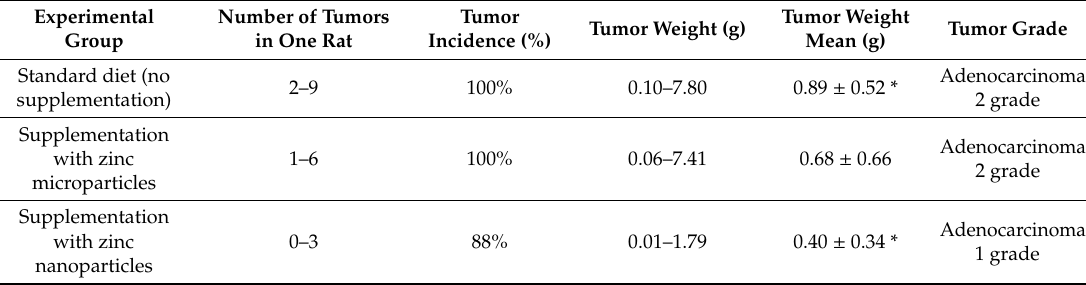
Table 2. Mammary tumor formation in individual experimental groups treated with 7,12-